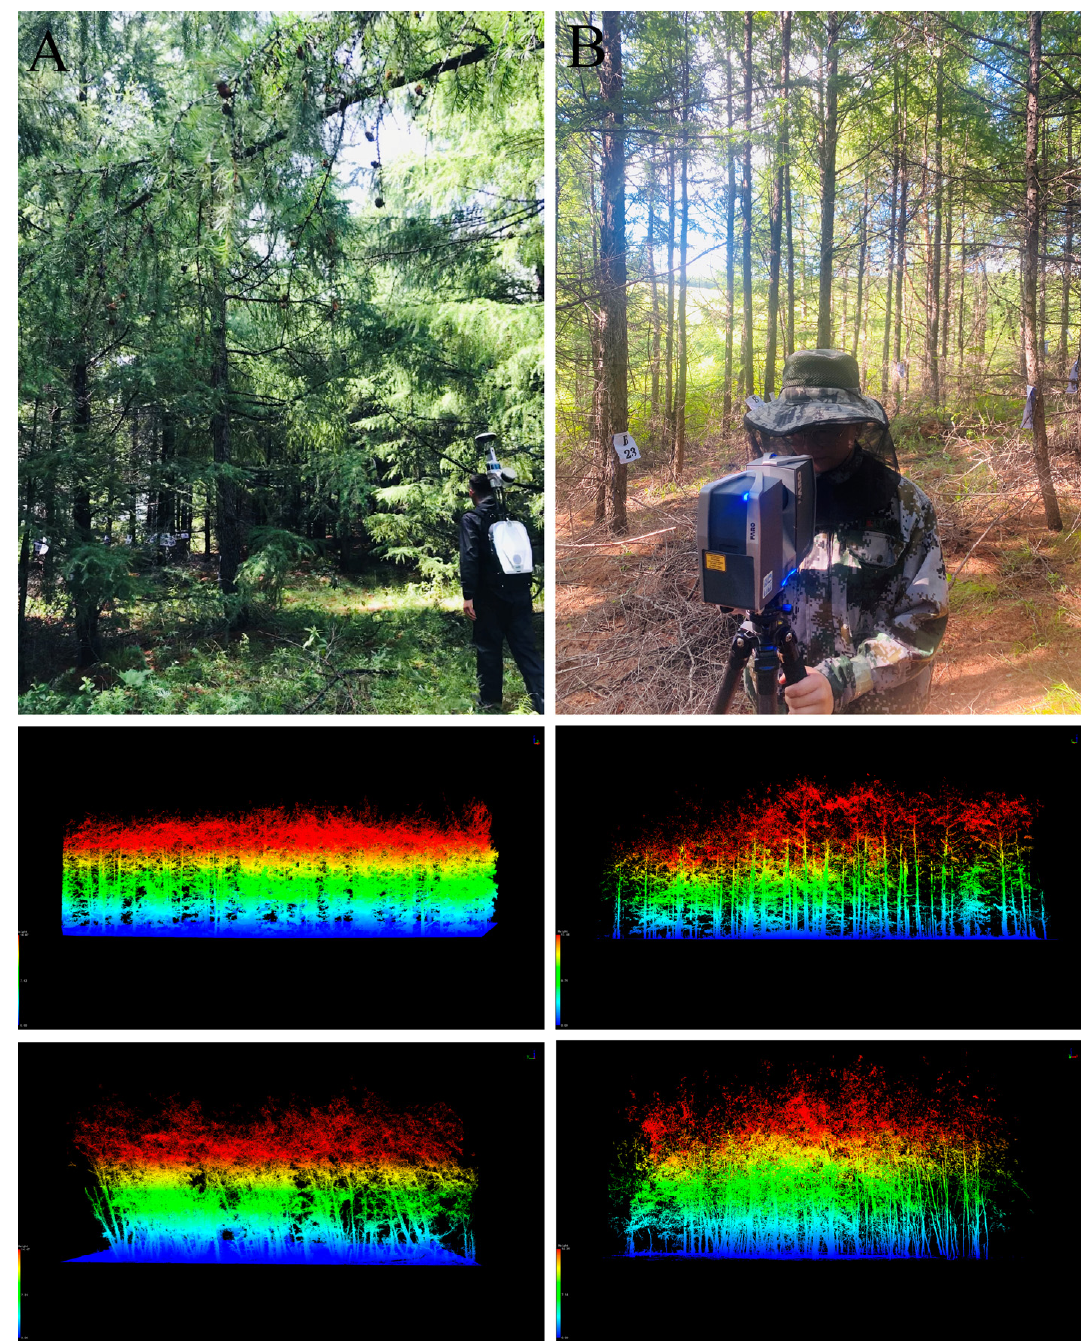
Figure 3. ( A ) Backpack LiDAR data acquisition and point cloud data. ( B ) TLS data acquisition and point cloud data.